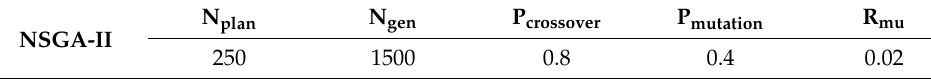
Table 2. Tuning results for the parameters of the algorithm.